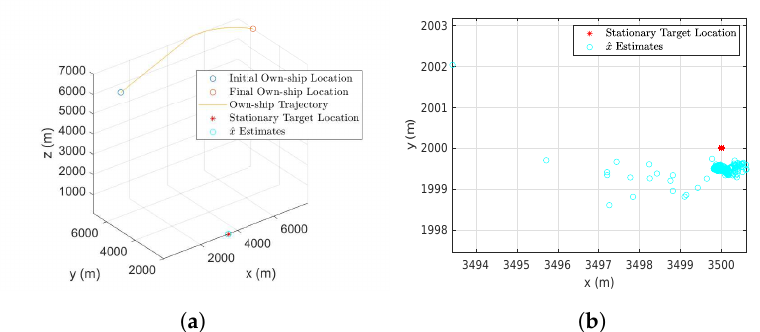
Figure 12. Tracking a stationary ground target with terrain uncertainty using an airborne angle-only sensor. ( a ) 3D CCS representation of the target own-ship geometry along with the estimates. ( b ) 2D CCS representation of the stationary target and the estimates.